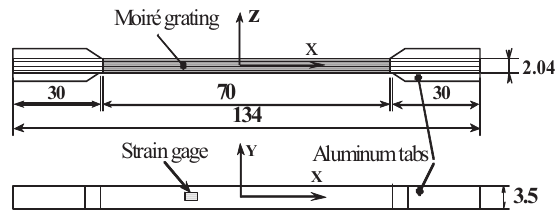
Fig. 2 AS4/PEEK laminate specimen geometry (mm)